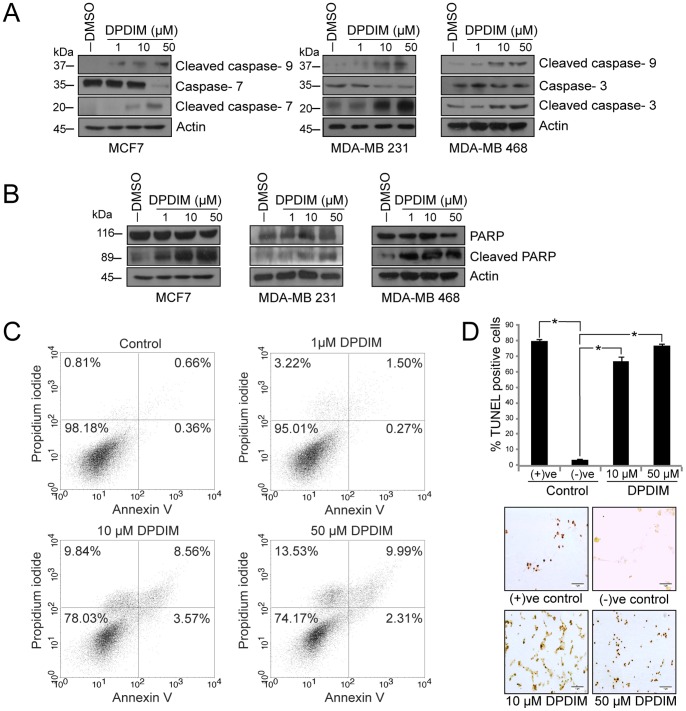
Activation of mitochondrial caspases and induction of apoptosis in DPDIM treated breast cancer cells.(A), Activation of mitochondrial caspases-9, 7 and 3 in 24 hr DPDIM treated cells were shown by IB. (B), Analysis of PARP cleavage was done by IB in MCF7 and MDA-MB 231 cells after 24 hr treatment with DPDIM. (C), Apoptotic cell population was evaluated after 24 hr of treatment by FACS analysis using double staining with Annexin V and PI. (D), In situ TUNEL assay showing inter-nucleosomal degradation of genomic DNA in 48 hr treated MCF7 cells. Cells were stained with DAB and counterstained with methylgreen. The % TUNEL positive cells were calculated and the quantitative evaluation represented in the bar diagram with SD. *indicates P<0.0001. All results are representative of three independent experiments.